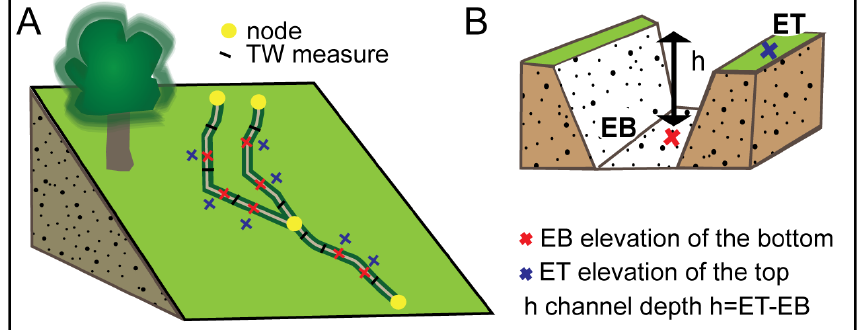
Figure 5. ( A ) Sketch of the channel mapping on satellite images. The yellow dots represent the nodes. Each channel is delimited by two consecutive nodes. ( B ) Sketch of the channel depth measurements. The crosses represent the positions of the floating